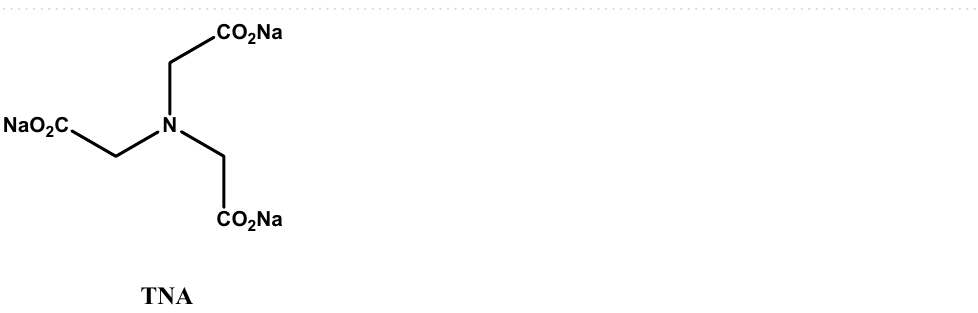
Figure 1. The chemical structure of trisodium nitrilotriacetate